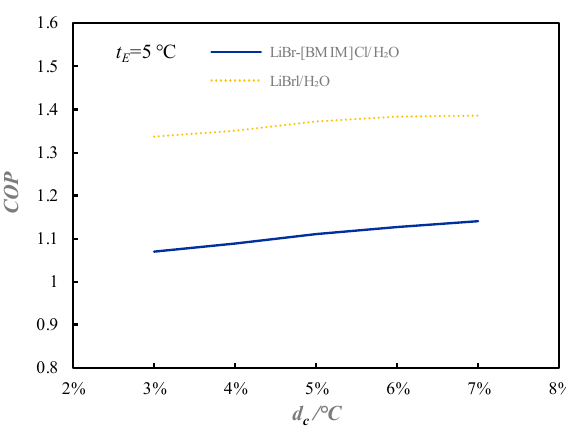
Figure 13. Variations of t HG with different d c .